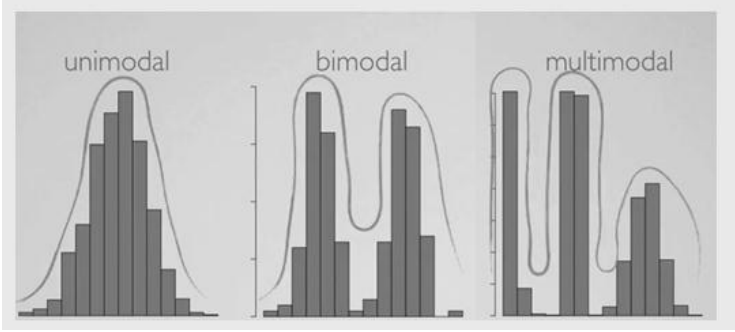
Figure 2. Different modality.